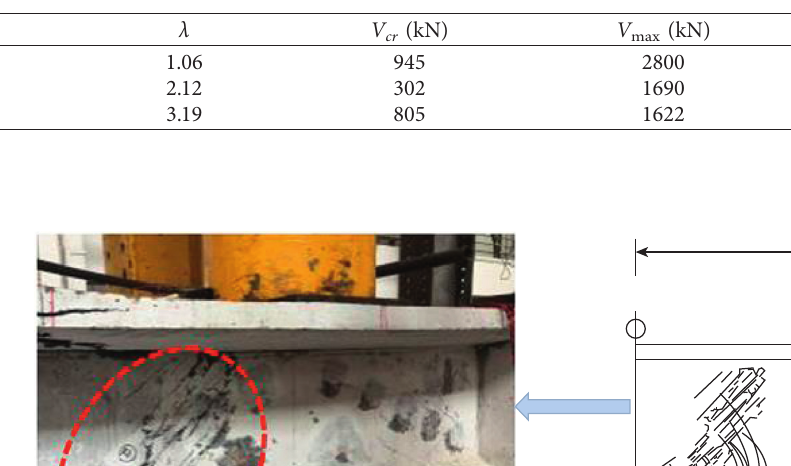
Table 4: Shear-resistance test results.